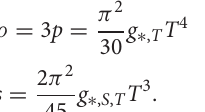
This gives for Equation (76) the